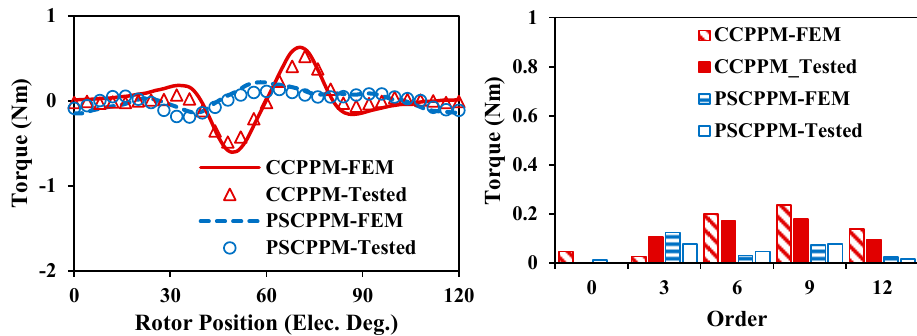
Figure 39. Cogging torque waveforms and spectra of 12s8p machines.